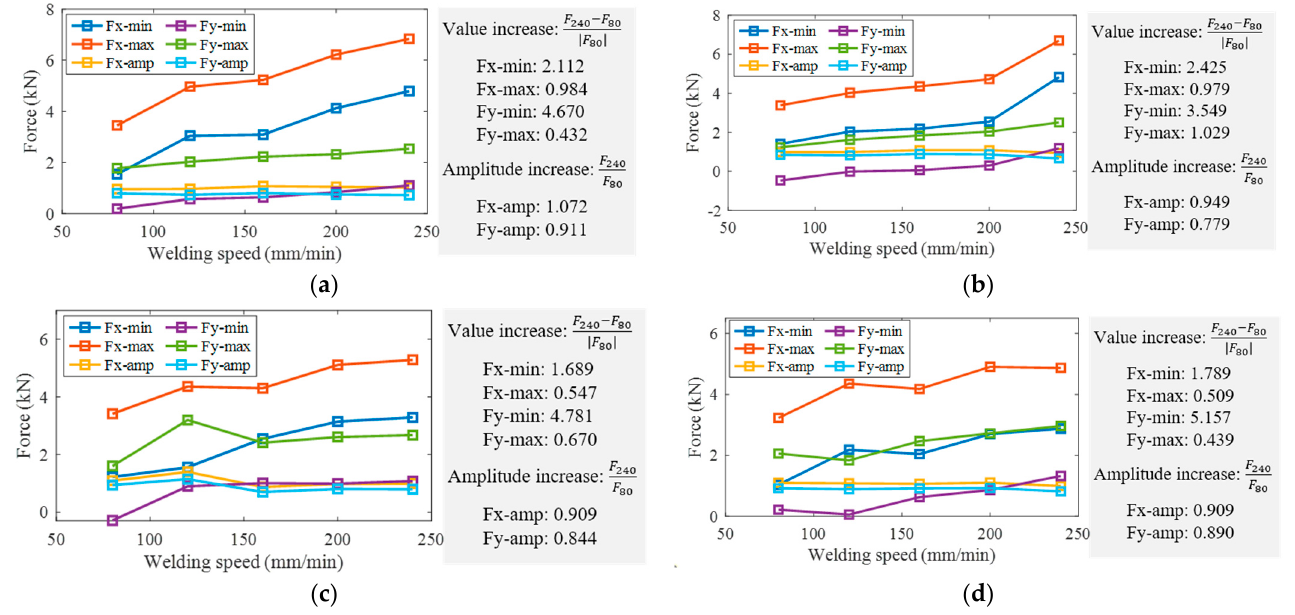
Figure 10. Influence of process parameters on characteristics of in-plane forces at rotational speeds of: ( a ) 300 r/min; ( b ) 400 r/min; ( c ) 500 r/min; ( d ) 600 r/min.